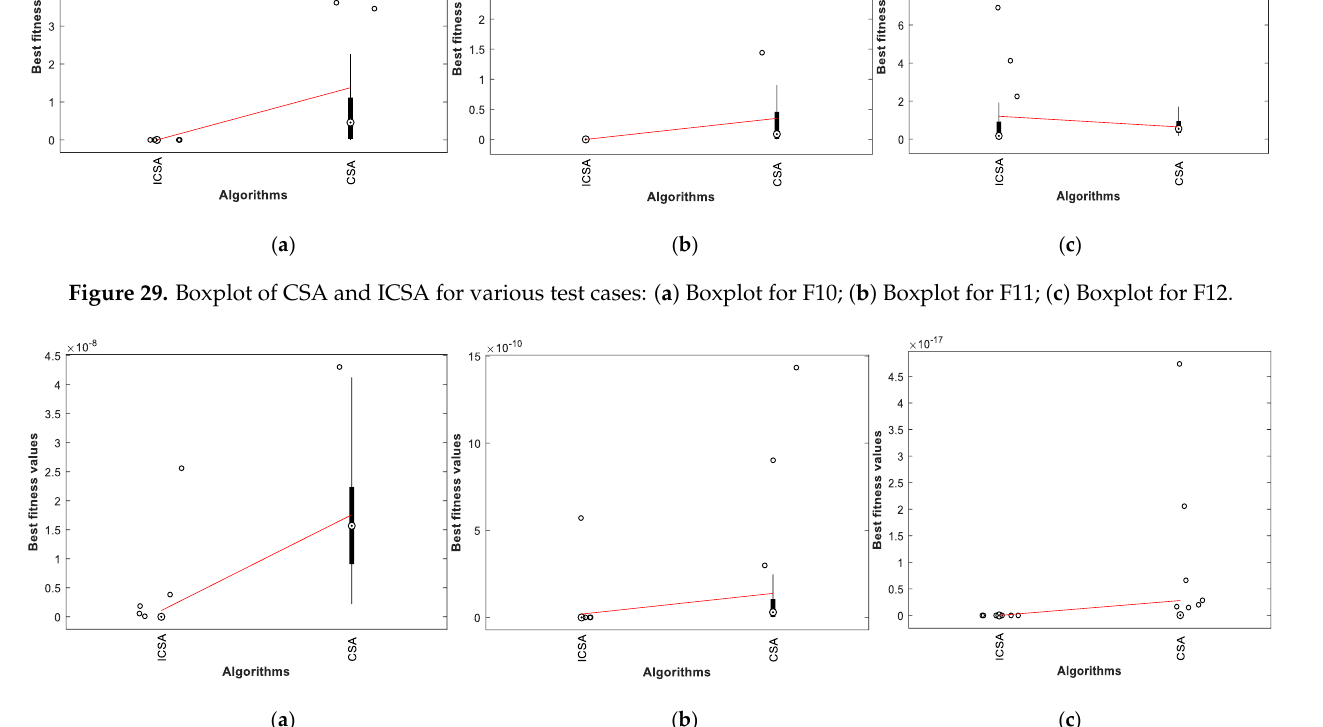
( c ) Figure 27. Boxplot of CSA and ICSA for various test cases : ( a ) Boxplot for F4; ( b ) Boxplot for F5; ( c ) Boxplot for F6.